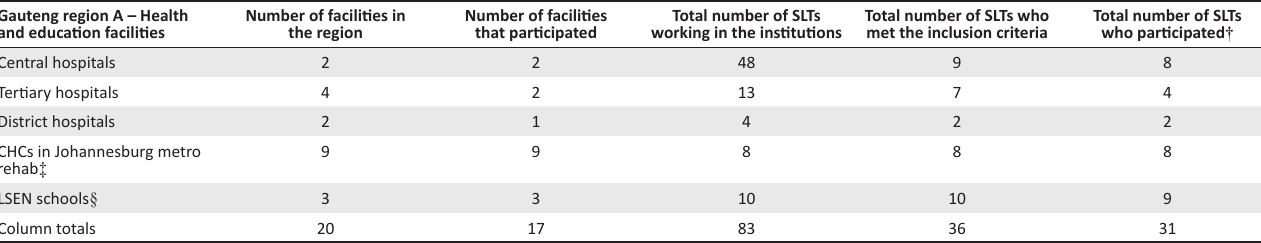
TABLE 1 : Number of speech-language therapists who participated in the study. Gauteng region A – Health and education facilities